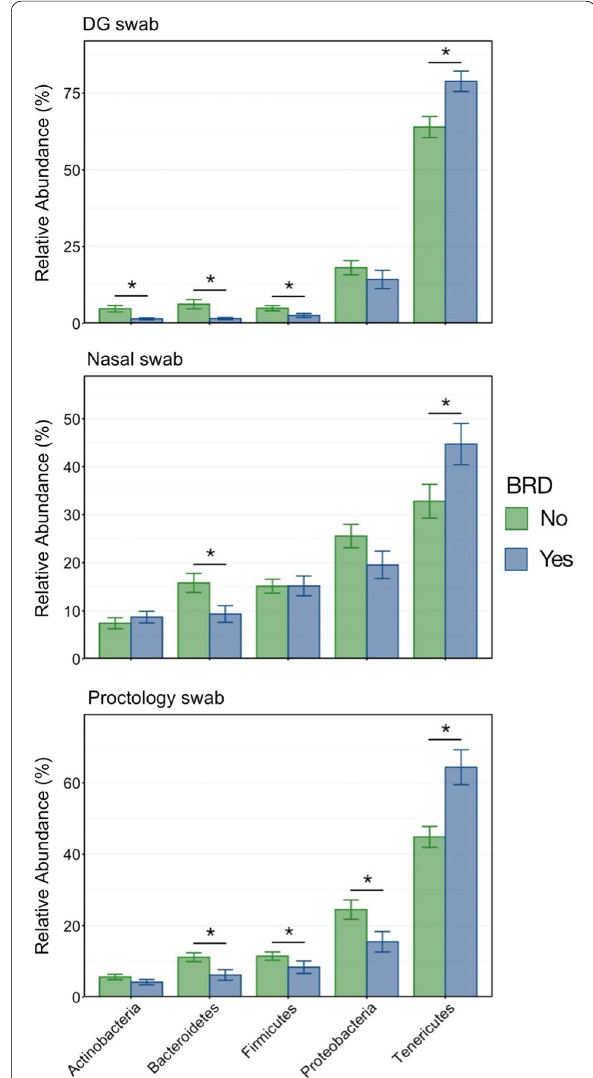
Fig. 8 Bar plot demonstrating differences in the relative abundance of each of the 6 most abundant phyla in BRD negative and BRD positive animals as collected with DG swabs, nasal swabs, or proctology swabs. Error bars display the standard error of the mean. Significant differences among relative abundances within each phylum are noted with an asterisk (Kruskal–Wallis analysis of variance by ranks, P <